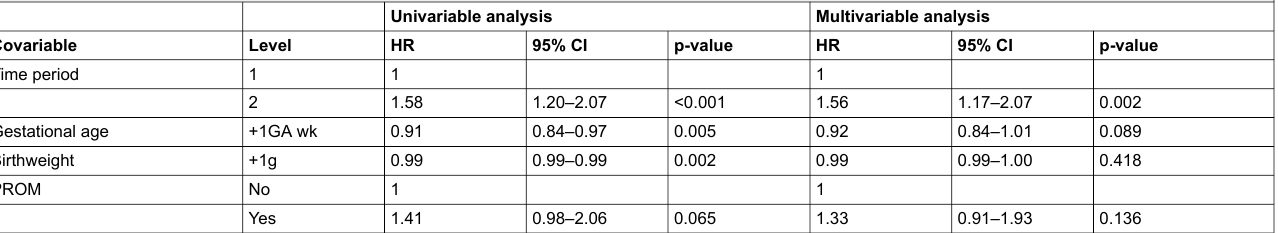
Table 3 : Uni- and multivariable hazard ratios (HRs) and 95% confidence intervals (CIs) for the time between birth and the first dose of antibiotics according to the time period, gestational age, birthweight and premature rupture of membranes